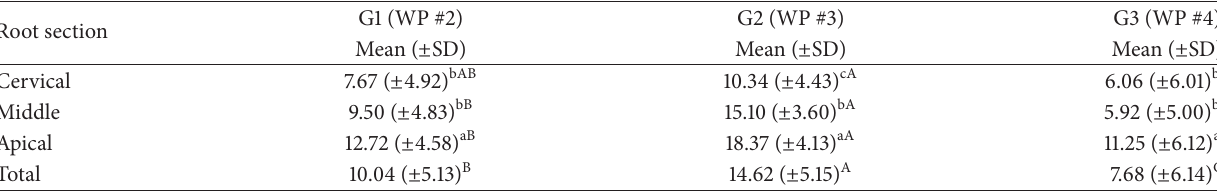
Table 2: Push-out bond strengths by drill size and location of root section (MPa).